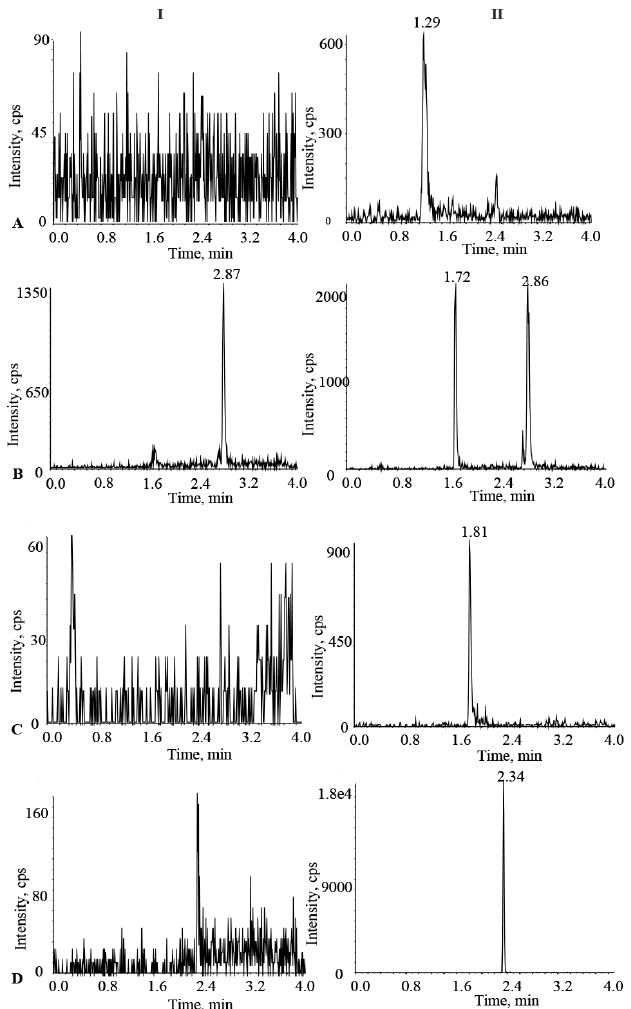
Figure 3. The chromatogram of analytes and IS in blank plasma ( I ). The chromatogram of analytes and IS at LLOQ concentration levels ( II ); ( A ) osimertinib; ( B ) aumolertinib; ( C ) furmonertinib; ( D ) IS.